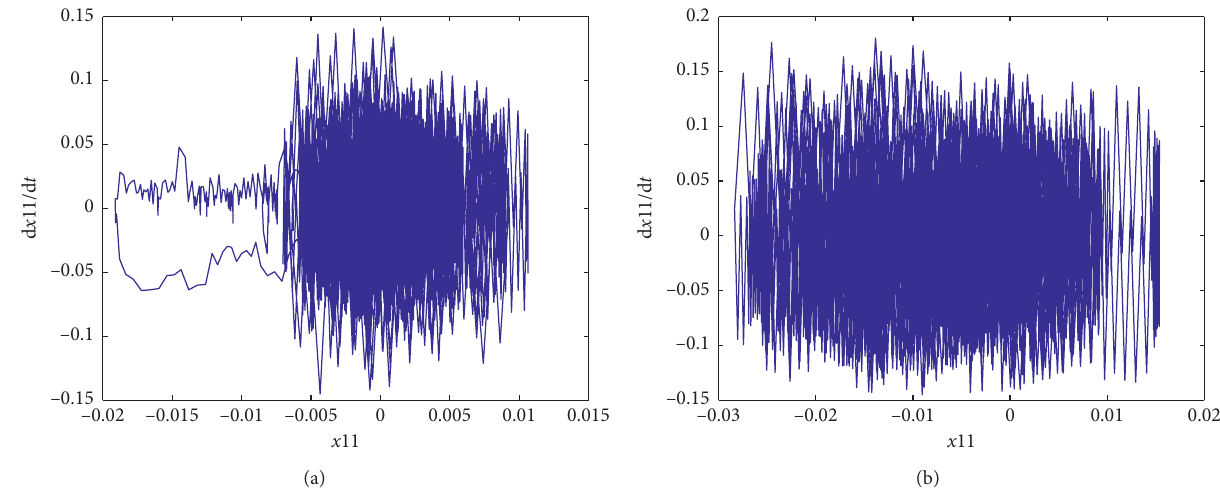
Figure 17: The region of the attraction set for Figure 16 and considering different values of Δ � 5% and Δ � 10%. (a) The region of the attraction set for Δ � 5%. (b) The region of the attraction set for Δ � 10%.